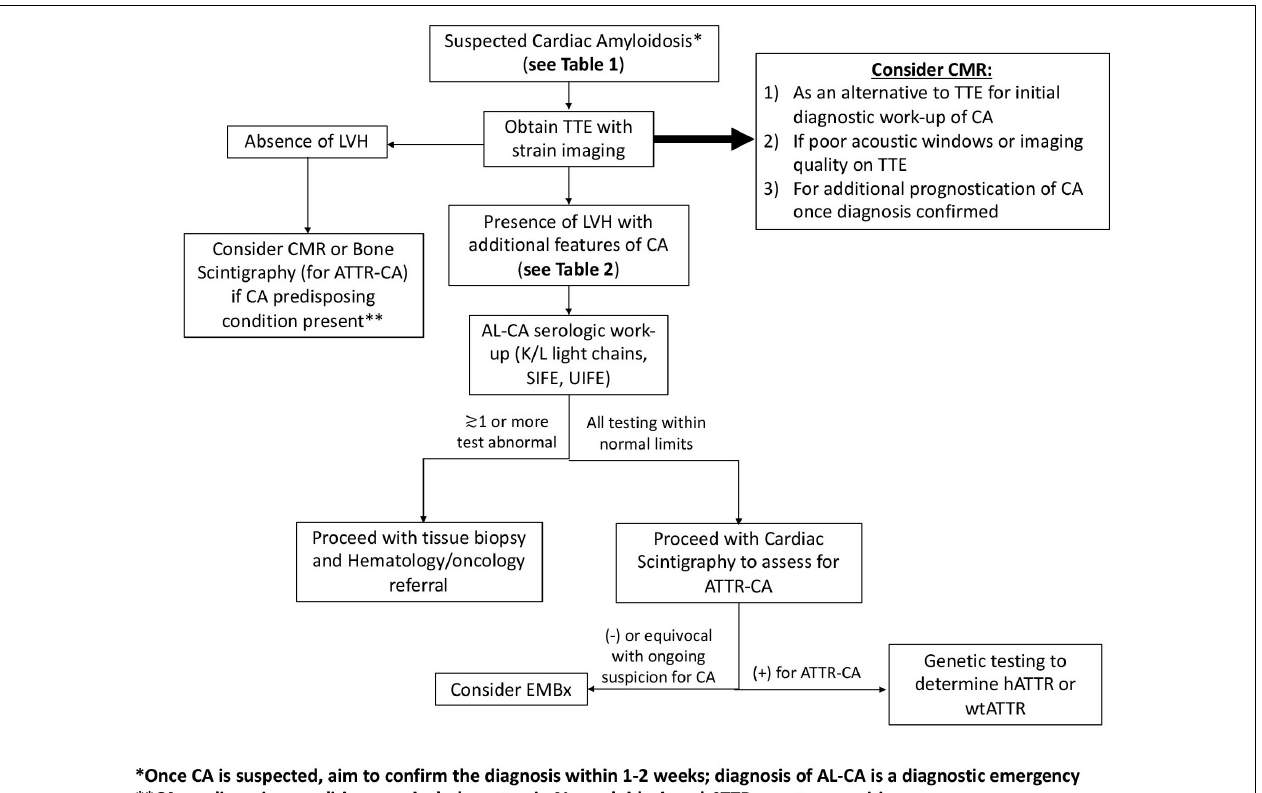
FIGURE 1 | Proposed algorithm for diagnosis of cardiac amyloidosis. Algorithm for patients being assessed for cardiac amyloidosis based on heart failure or risk factors for AL or ATTR-CA. EMBx, endomyocardial biopsy; CMR, cardiac magnetic resonance imaging; LVH, left ventricular hypertrophy; SIFE, serum protein electrophoresis with immunofixation; TTE, transthoracic echocardiogram; UIFE, urine protein electrophoresis with